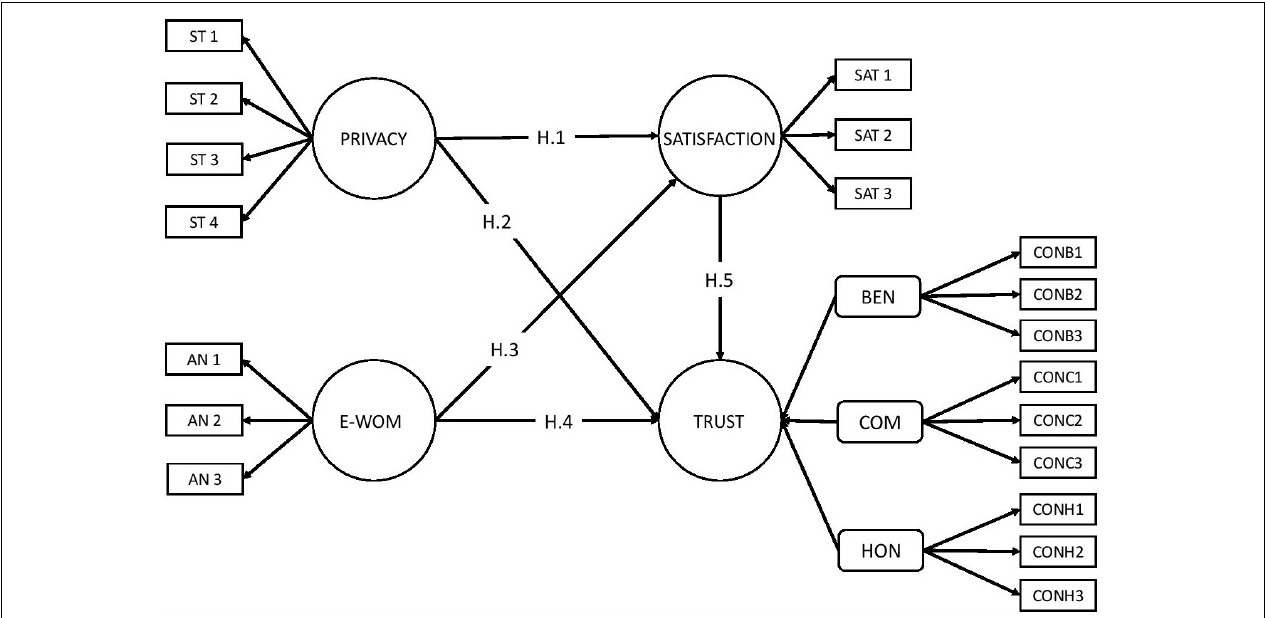
FIGURE 1 | Proposed research model. Source: own